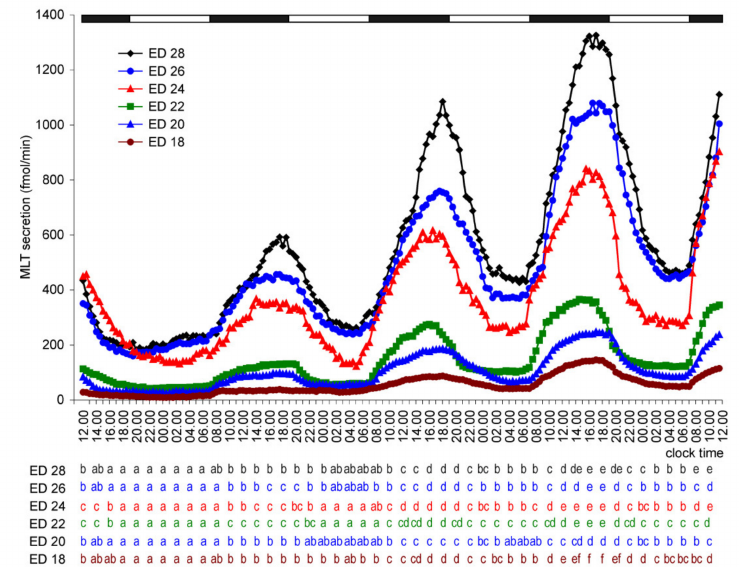
Figure 3. Secretion of MLT (means, n = 4) from pineal organs of goose embryos incubated under a reversed 12D:12L cycle (photophase from 19.00 to 07.00). Letters show differences between time- points within a group of explants prepared from embryos of the same age. The identical letters indicate means, which are not significantly different.